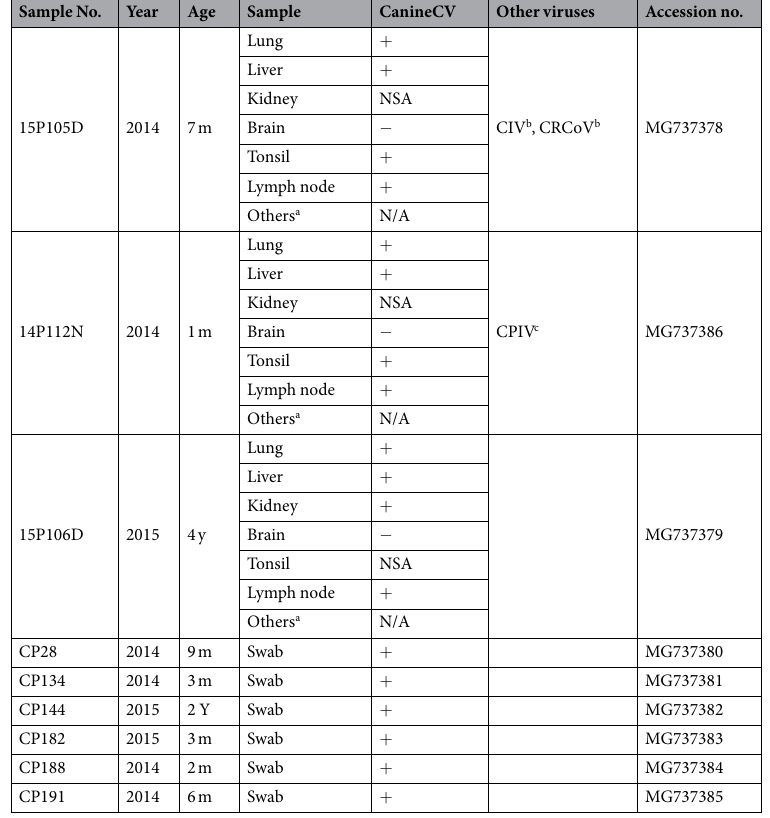
Table 1. Overview of CanineCV-positive samples. a Other tissues included small intestine, gall bladder, heart and thymus; b Virus detection in nasal swab only; c Virus detection in oral swab only. Abbreviation: m, month; y, year; N/A, no data available; NSA, no sample